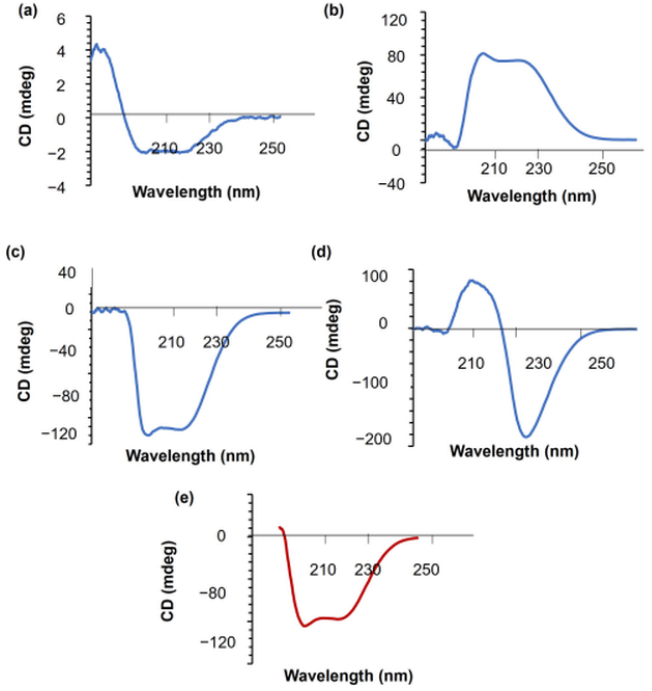
Figure 12. CD-UV analysis of the hydrogels: ( a ) M6.4-100, ( b ) M6.4-75, ( c ) A6.4-100, ( d ) M8.2-100, and ( e ) pure BSA.